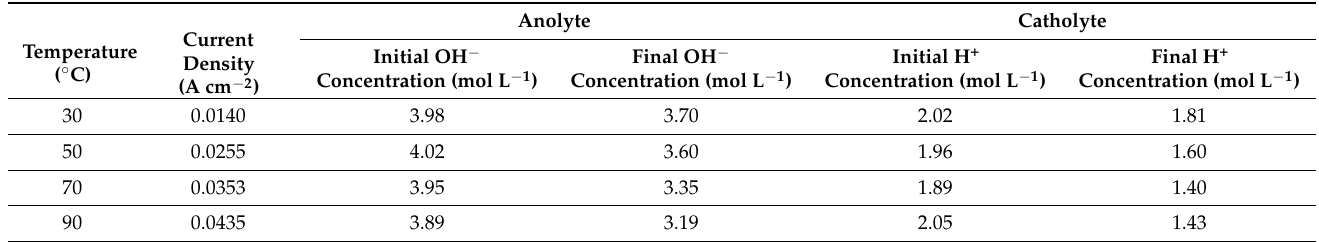
Figure 5. Preliminary stability test of the glycerol alkaline-acid electrochemical reformer for 12 h at the current density in which the maximum power density of the spontaneous region was achieved. Table 3. Initial and final OH − and H + concentrations over the chronoamperometric. Table 4. Comparison between the real and theoretical proton concentration according to Faraday’s